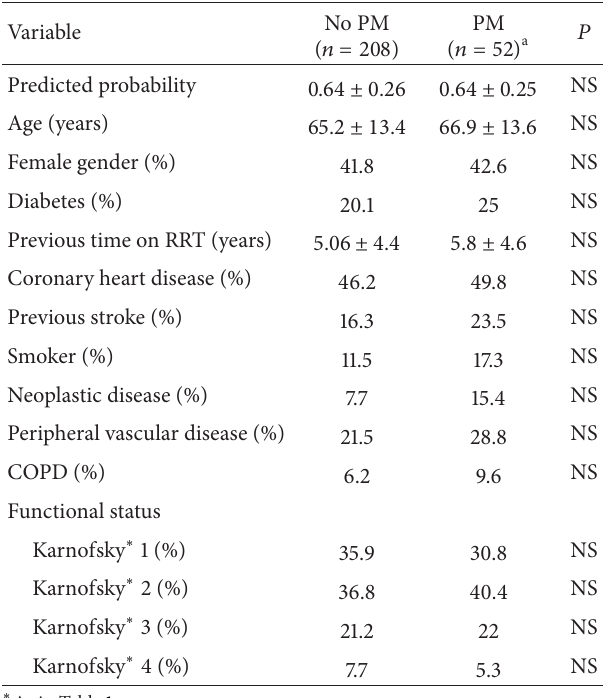
Table 4: Characteristics of the PM patients by survival